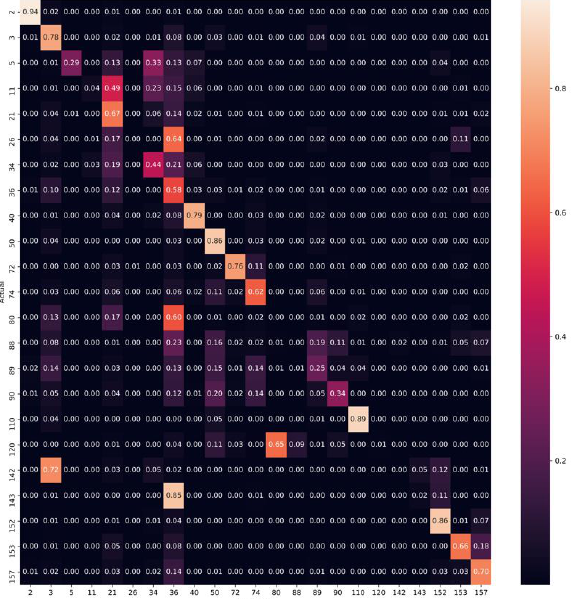
Figure 8 confusion matrix of adjustedl sample